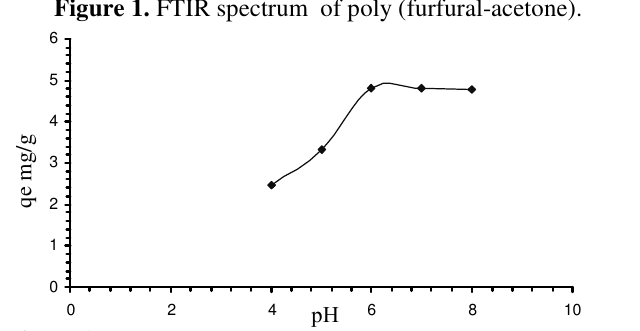
Figure 2. Effect of pH on the adsorption of Cu(II) on to PFA